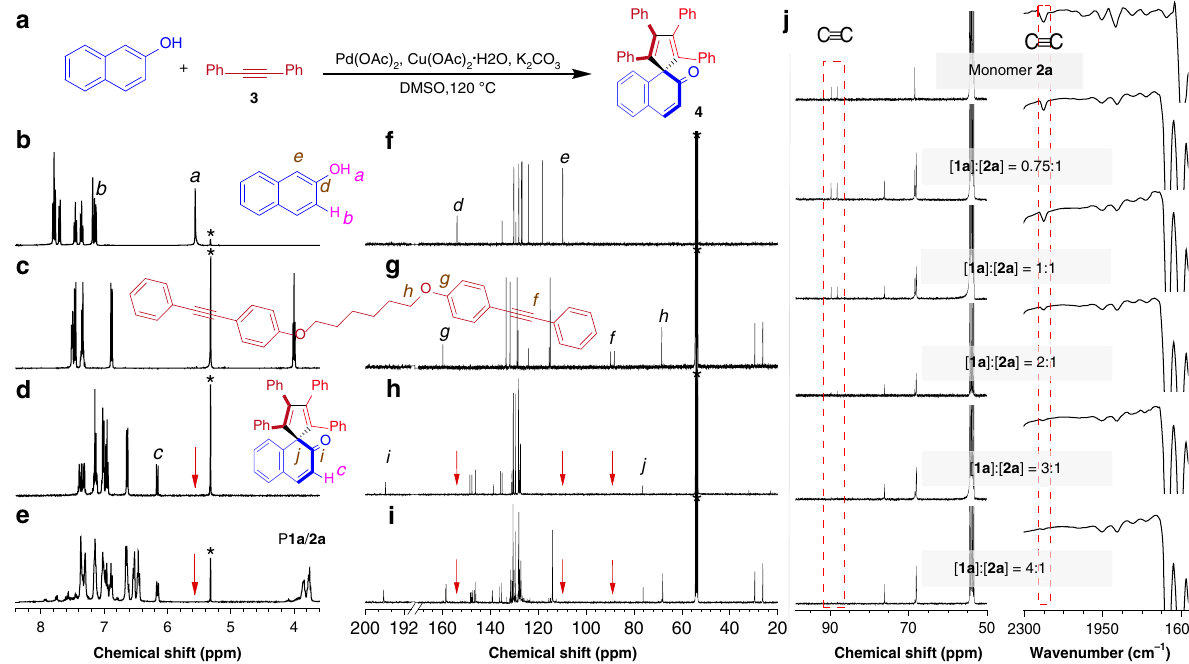
Fig. 2 Structural characterization and analysis of the polymeric products. a Synthetic route to model compound 4 . b – e 1 H NMR spectra of b monomer 1a , c monomer 2a , d model compound 4 , and e P 1a / 2a in CD 2 Cl 2 . f – i 13 C NMR spectra of f monomer 1a , g monomer 2a , h model compound 4 , and i P 1a / 2a in CD 2 Cl 2 . j 13 C NMR spectra in CD 2 Cl 2 (left) and IR spectra (right) of monomer 2a and P 1a / 2a generated from polymerizations at different monomer ratios (sample taken from Table 1, entries 1 – 5,